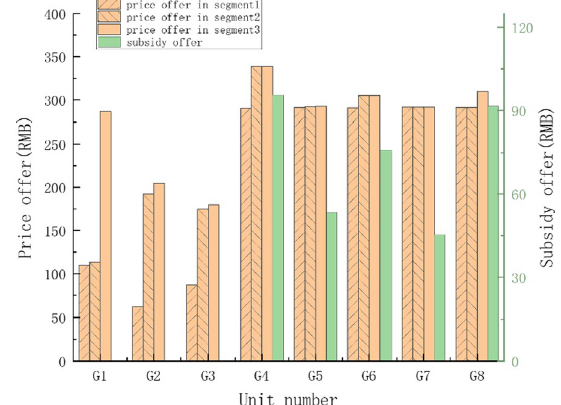
Fig. 9 Stable bidding prices of generation units during different segments after 15 rounds of the dual-market clearing process